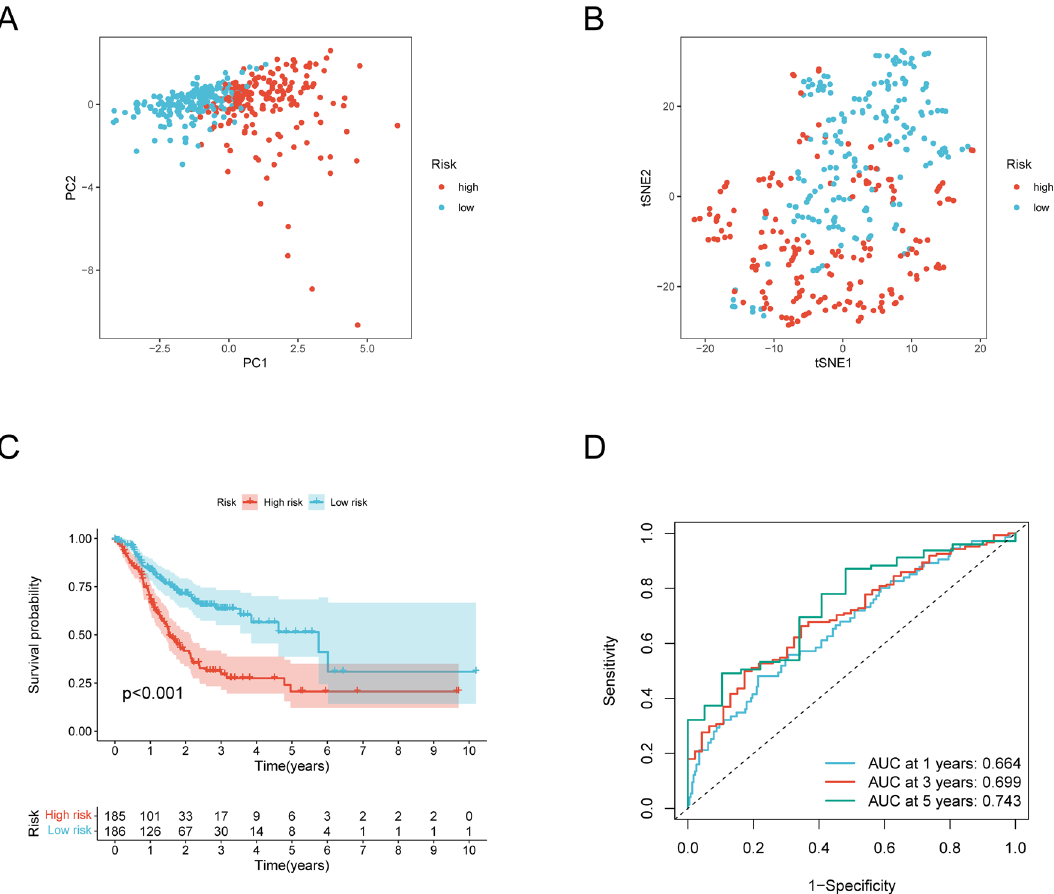
Figure 6. Prognosis value of necroptosis-related prognostic signature in the TCGA-GC cohort. ( A ) Principal component analysis plot. ( B ) T-distributed neighbor embedding plot. ( C ) Kaplan–Meier curves (Log-rank test, P < 0.001) for OS of high- and low-risk groups. ( D ) The AUC of the prediction of 1, 3, 5 ‐ year survival rate of GC. OS, overall